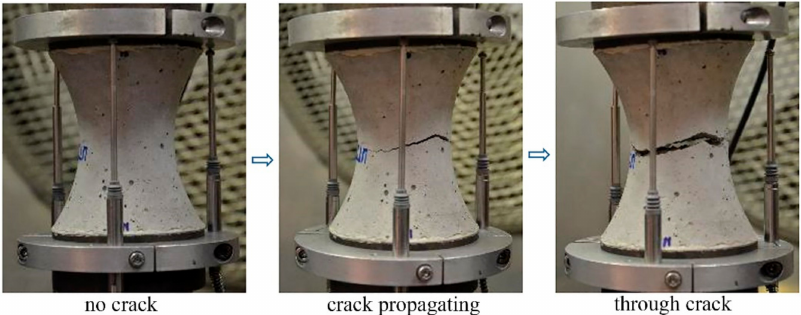
Figure 5. Crack development during a deformation controlled uniaxial tensile test.